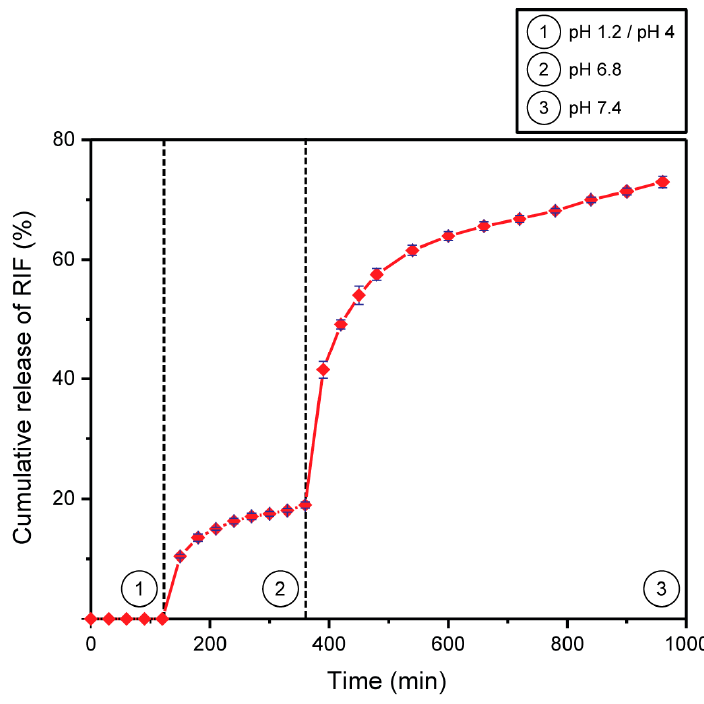
Figure 8. Cumulative release of RIF (mean ± standard deviation; n = 3).